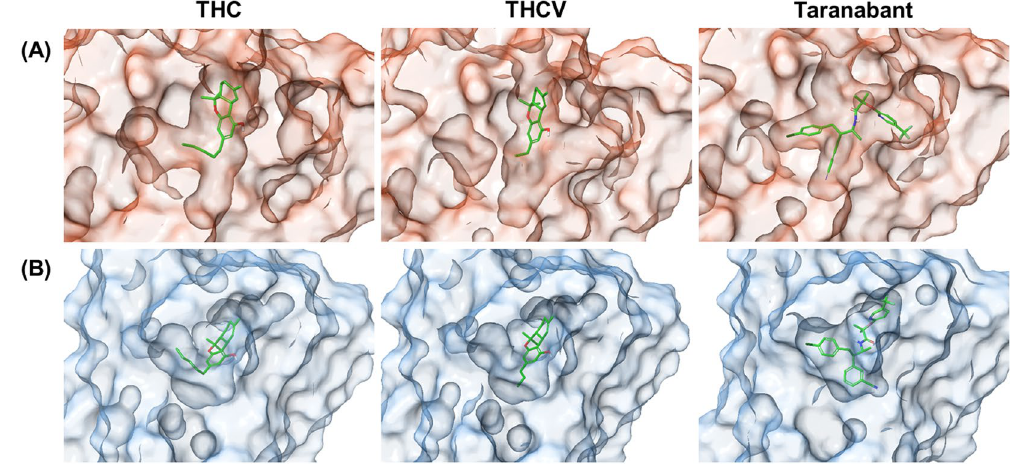
Figure 3. Binding poses of three ligands. The three ligands, including THC, THCV, and taranabant, were docked to the ( A ) inactive and ( B ) active conformations of CB1 receptor.